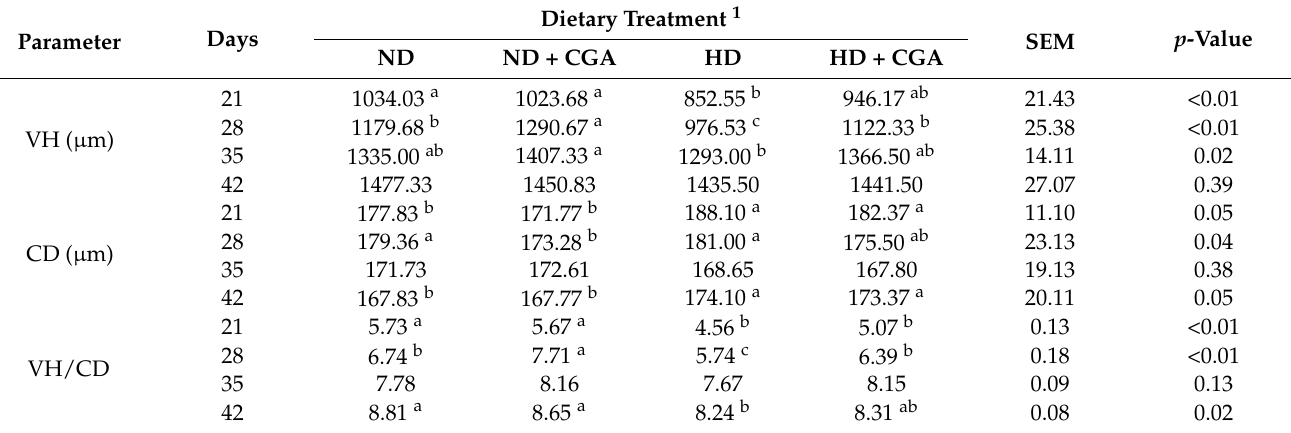
Table 4. Effects of CGA on jejunal morphology of broilers under HD